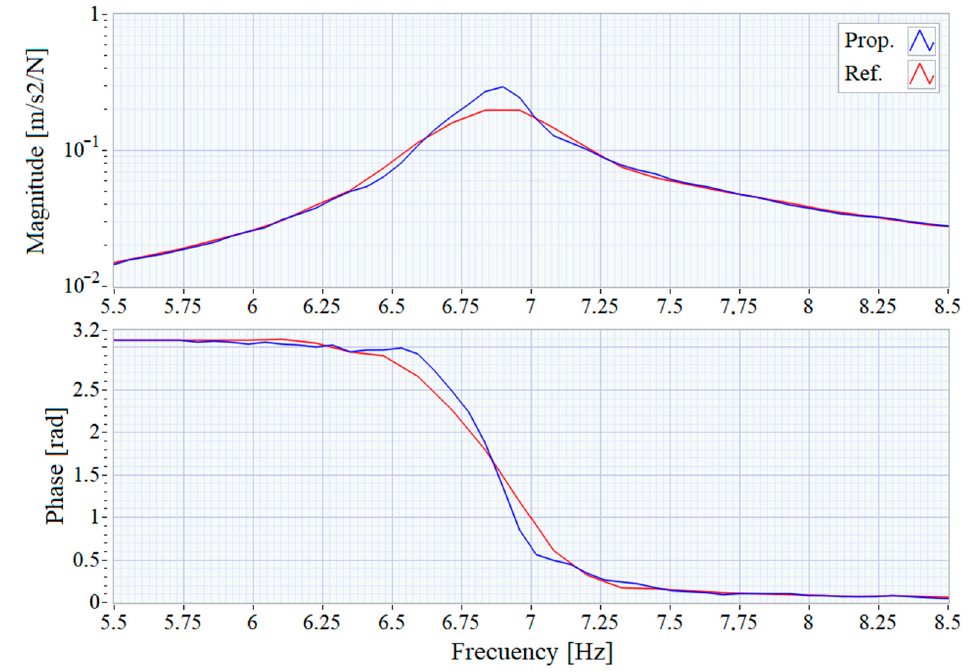
Figure 12. Frequency Response Function with resolution increased. Table 2. Estimated cost ( € ) of the reference and proposed